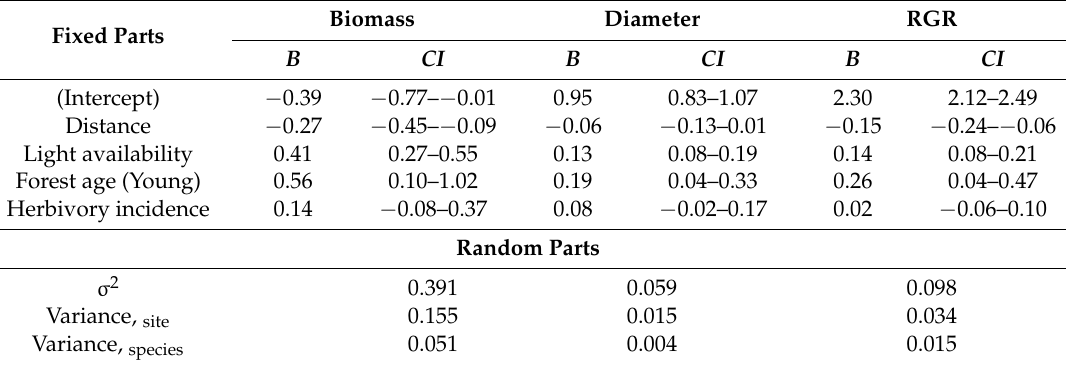
Table A4. Results from linear mixed effects models of biomass, diameter, and relative growth rate. Estimates ( B ) and 95% confidence intervals ( CI ) are reported using the scaled predictor